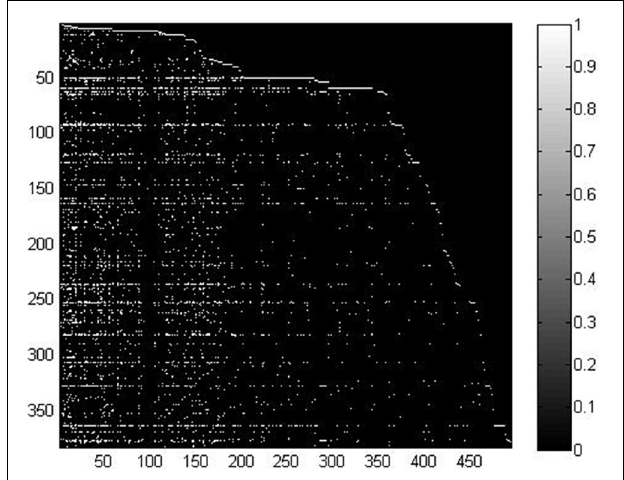
FIGURE 1 | Visualization of the miRNA–disease association